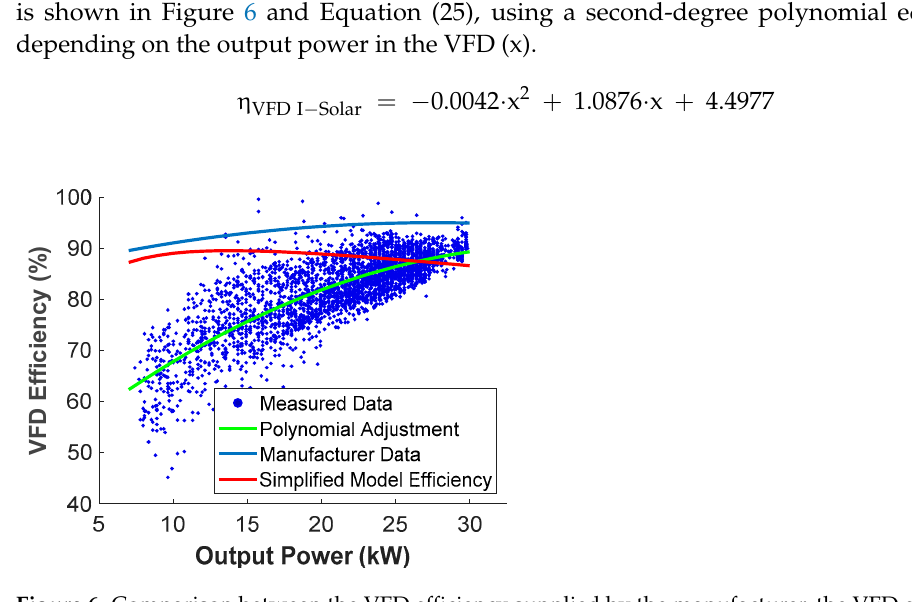
Figure 6. Comparison between the VFD efficiency supplied by the manufacturer, the VFD efficiency measured and the VFD efficiency obtained through the general equation of the simplified method.